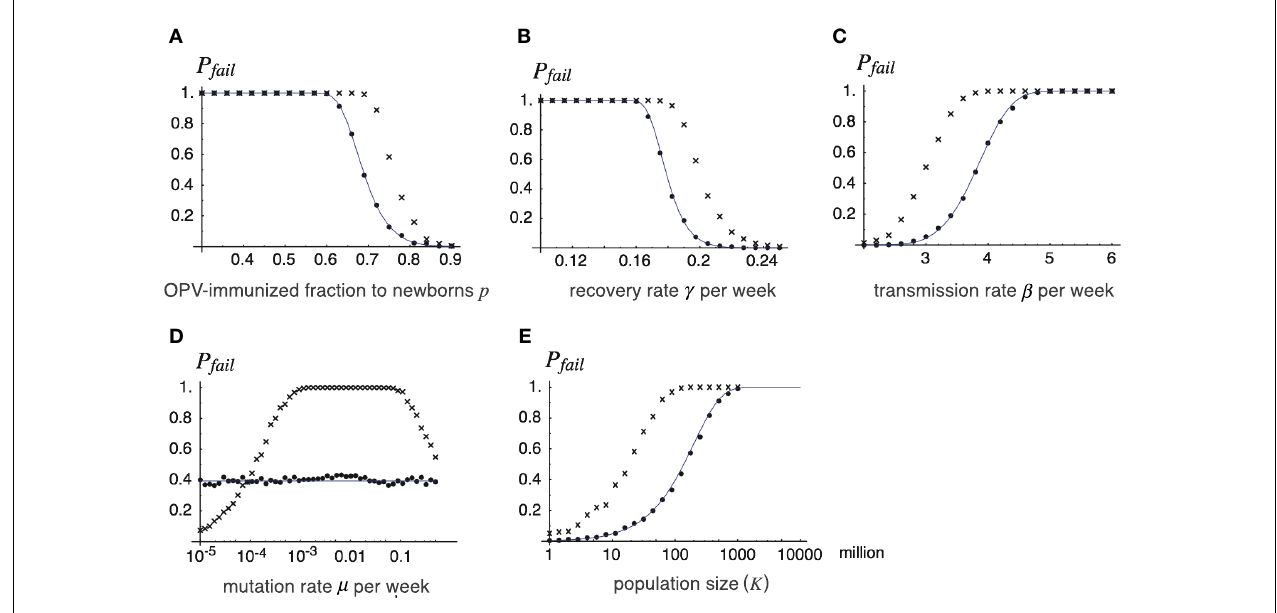
= γ = 0.18, m = 0.1, K = 10 8 , and u = 0.00025.Varying parameters are: γ = γ FIGURE 5 |The probability of the failure of global eradication as a v a function of epidemiological and genetic parameters. Each panel shows (A) fraction p of OPV immunization before its cessation, (B) recovery rate γ , how the probability of failing the global eradication P fail = 1 − P ext depends on (C) transmission rate β , (D) mutation rate μ , (E) total population size K . Lines: the probability of failure obtained from formula (11) in the text (for β v = β a = β ), a chosen parameter, where lines show analytical results drawn from P ext dots: the proportion of failing eradications in 1000 independent runs of the defined in Eq. 11, and dots show Monte Carlo simulation results. Except for Monte Carlo simulation for β v = β a = β , and cross-hatched: that for β v = β , the varying parameter in each panel, the parameters are fixed as p = 0.7, β = 3.7 ( β β = β = β for dots and lines, and β = β , β = β /2 for cross-hatched), = β v a v a a